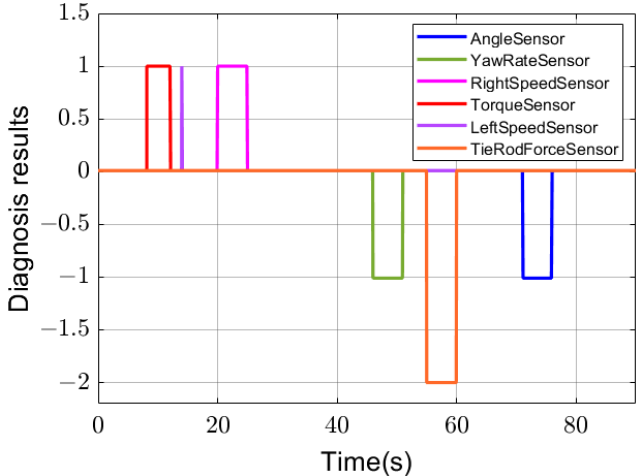
Figure 4. An example of the diagnosis results for six sensors: steering wheel angle sensor with a negative offset ( − 1), yaw rate sensor with a negative offset ( − 1), right wheel speed sensor with a positive offset (+1), steering wheel torque sensor with a positive offset (+1), left wheel speed sensor with a positive offset (+1), and tie rod force sensor with a total loss ( − 2). (2)